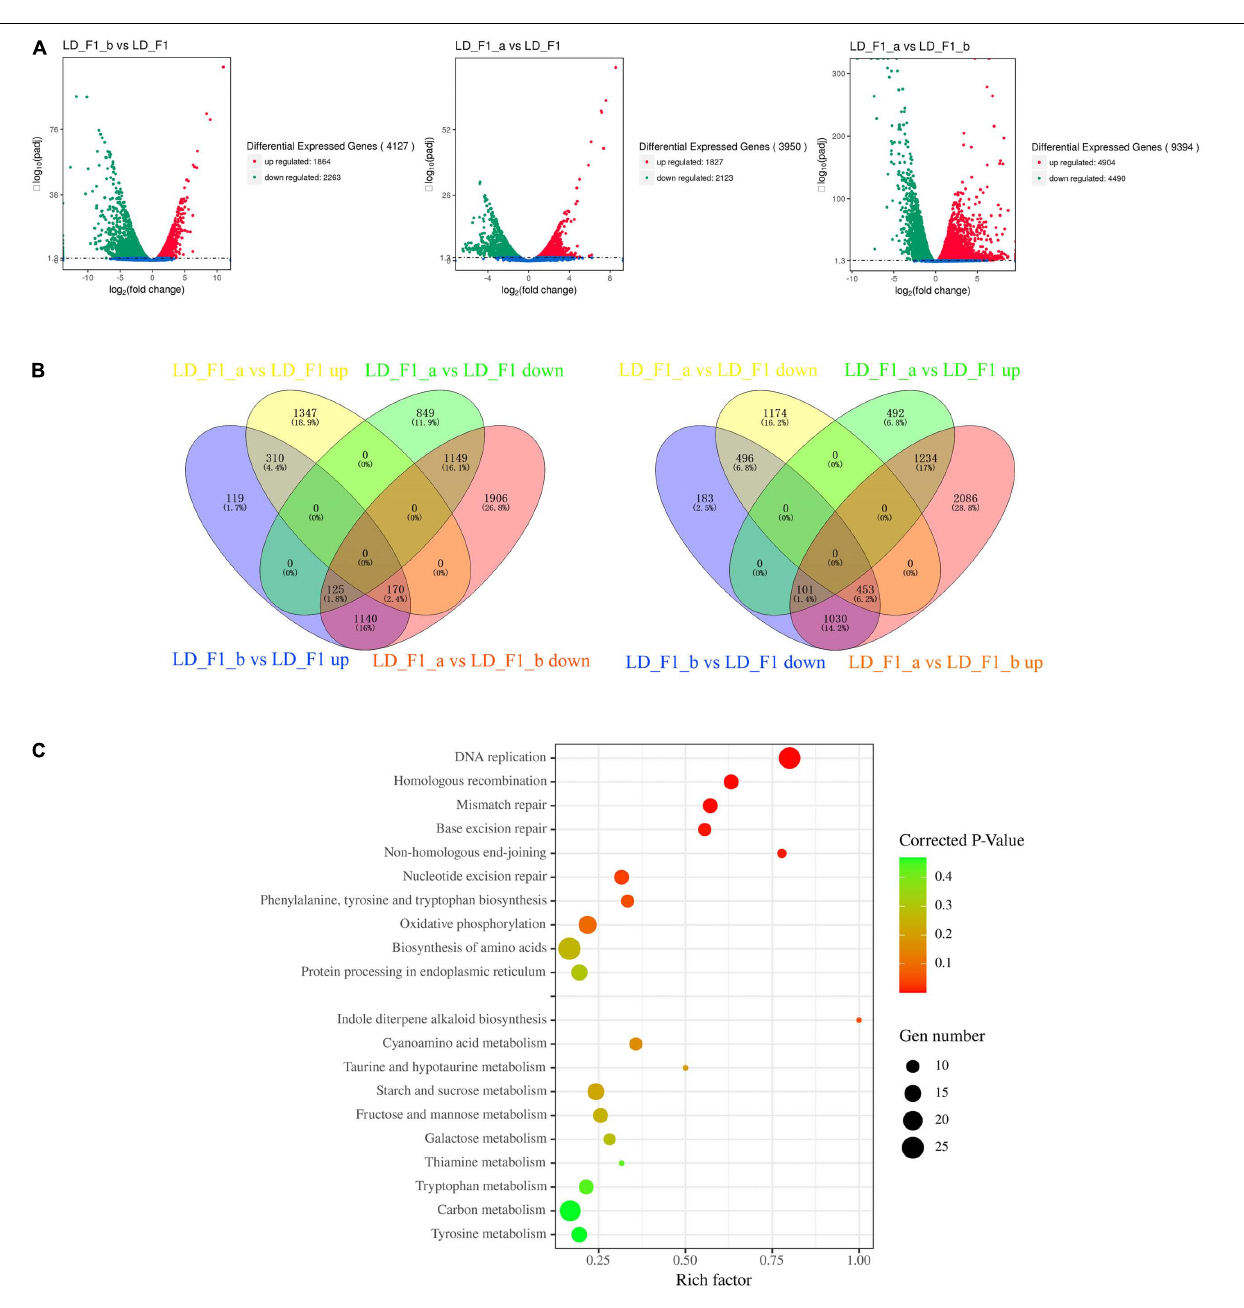
FIGURE 10 | Aspergillus flavus genes that were differentially expressed in response to AfPV1 and Satellite RNA that were identified by RNA-Seq. (A) Volcano plot of RNA-Seq data using Log 2 fold change and Log 10 (padj). X and Y axes represent Log 2 -converted fold change and Log 10 -converted padj. (B) Venn diagrams illustrating the number of genes that were differentially expressed in subsets of the virus-free isolate (LD-F1), AfPV1-infected isolate (LD-F1-b), and AfPV1- and SatRNA-infected isolate (LD-F1-a). (C) Bubble chart for KEGG pathway enrichment analysis of different expression in response to AfPV1 and Satellite